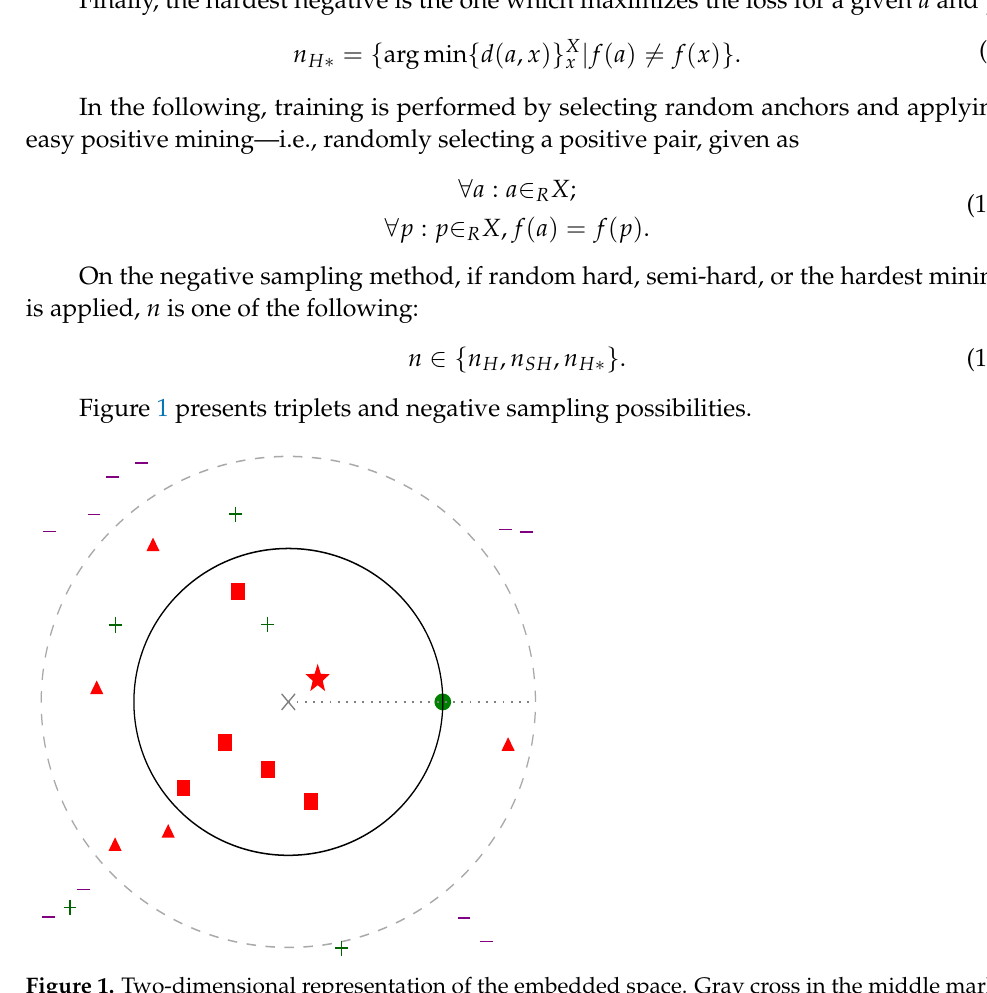
Figure 1. Two-dimensional representation of the embedded space. Gray cross in the middle marks the anchor element, a , and a green point shows a positive pair, p . d + positive distance is therefore defined and represented as a circle around a . Marginal distance ( d + + m ) is similarly shown as a dashed circle. The closest negative sample, which provides the highest loss, is represented with a star; other elements where d − < d + are shown with squares, and triangles represent negatives where d + < d − < d + + m . Other positive and negative data points are represented with plus and minus signs,